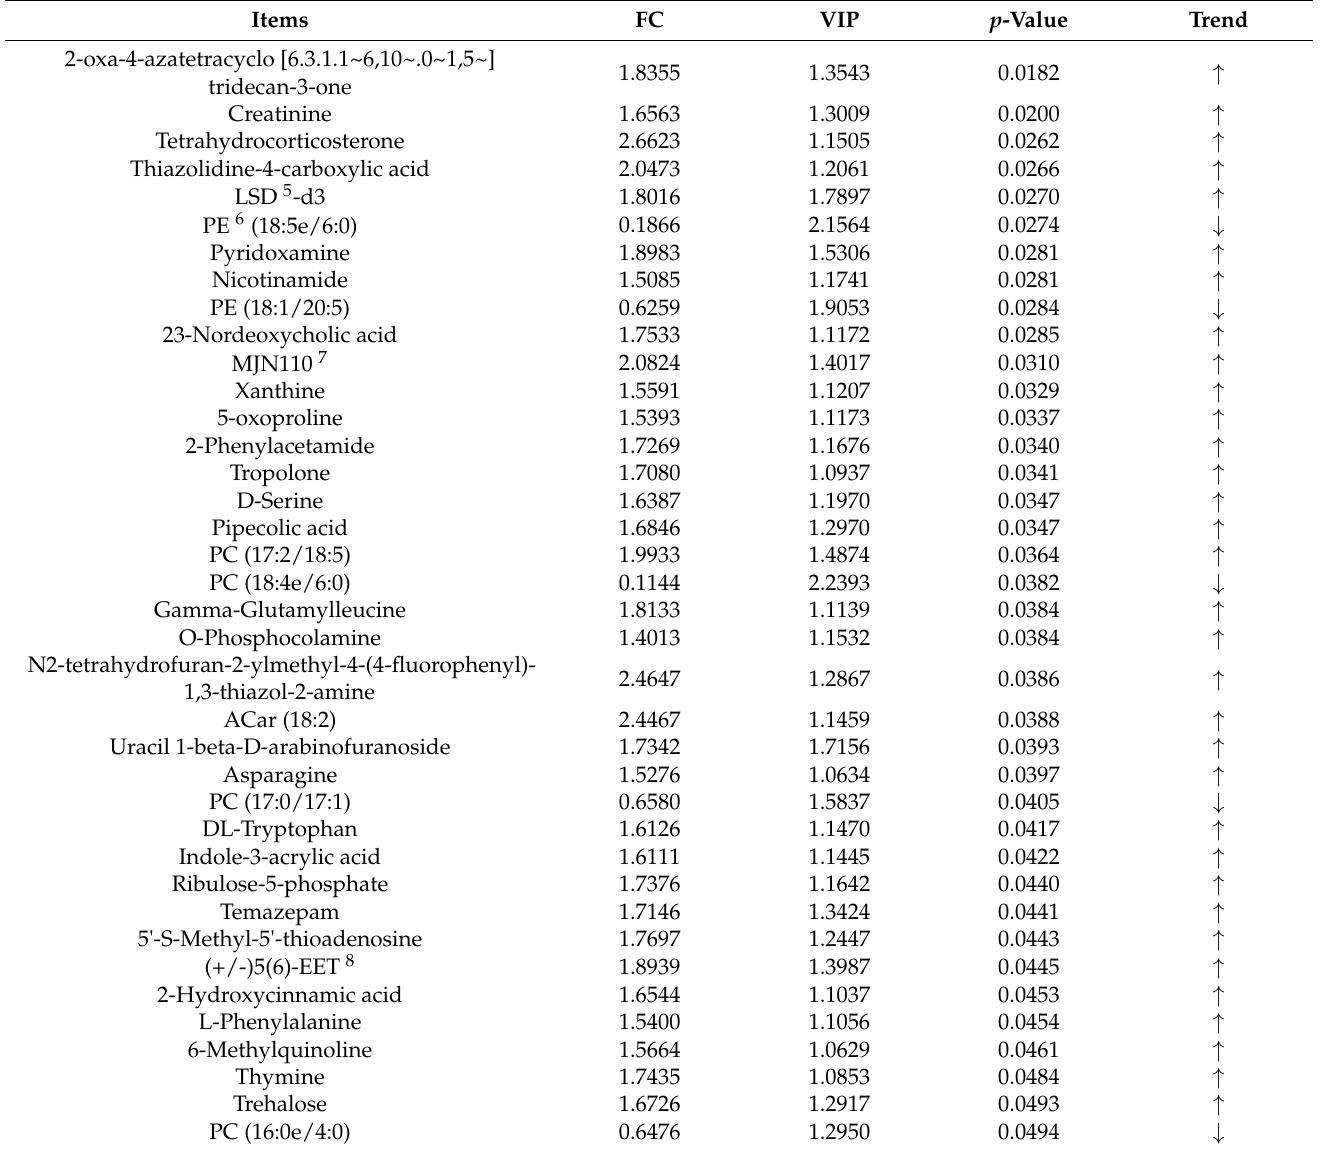
1 ↑ represents upward adjustment; ↓ represents downward adjustment. 2 ACar represents acylcarnitine. 3 UDP represents uridine diphosphate. 4 PC represents phosphatidycholine. 5 LSD represents lysergic acid diethylamide. 6 PE represents phosphatidylethanolamine. 7 MJN110 represents monoacylglycerol lipase inhibitor. 8 EET represents epoxyeicosatrienoic acid. The same as the table